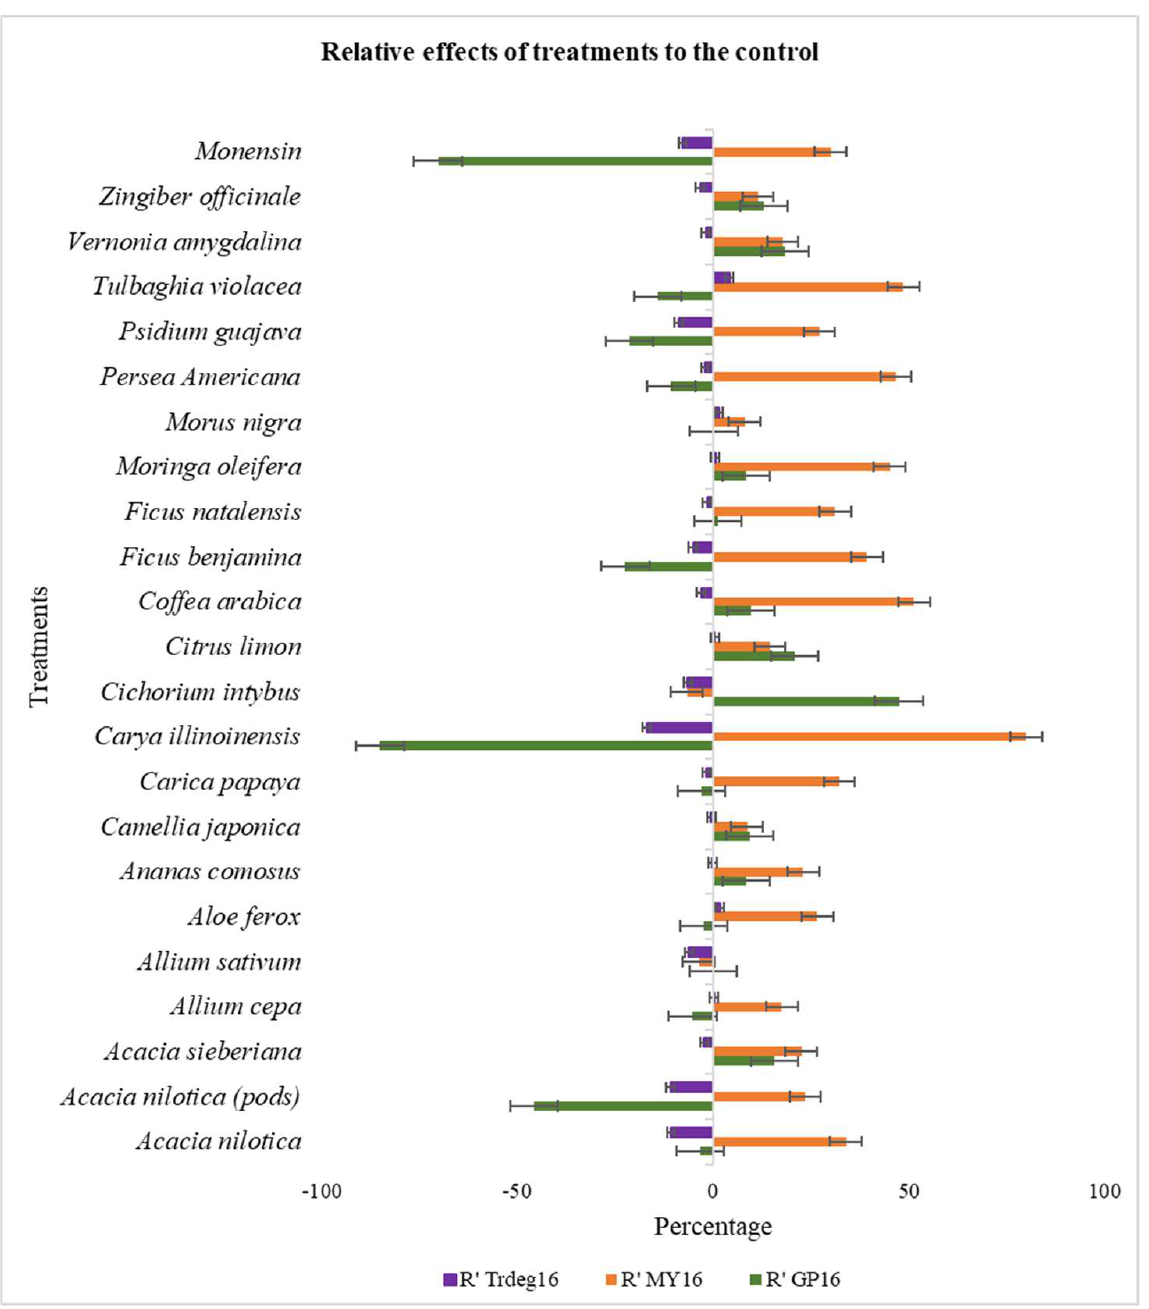
Figure 1. Chart presenting the effects of the treatments (plant extracts and monensin sodium) relative to the control on true degradability, microbial yield, and gas production at 16 h of incubation of Themeda triandra hay. R’ Trdeg—effect on true degradability, R’MY—effect on microbial yield, R’ GP - effect on gas production.